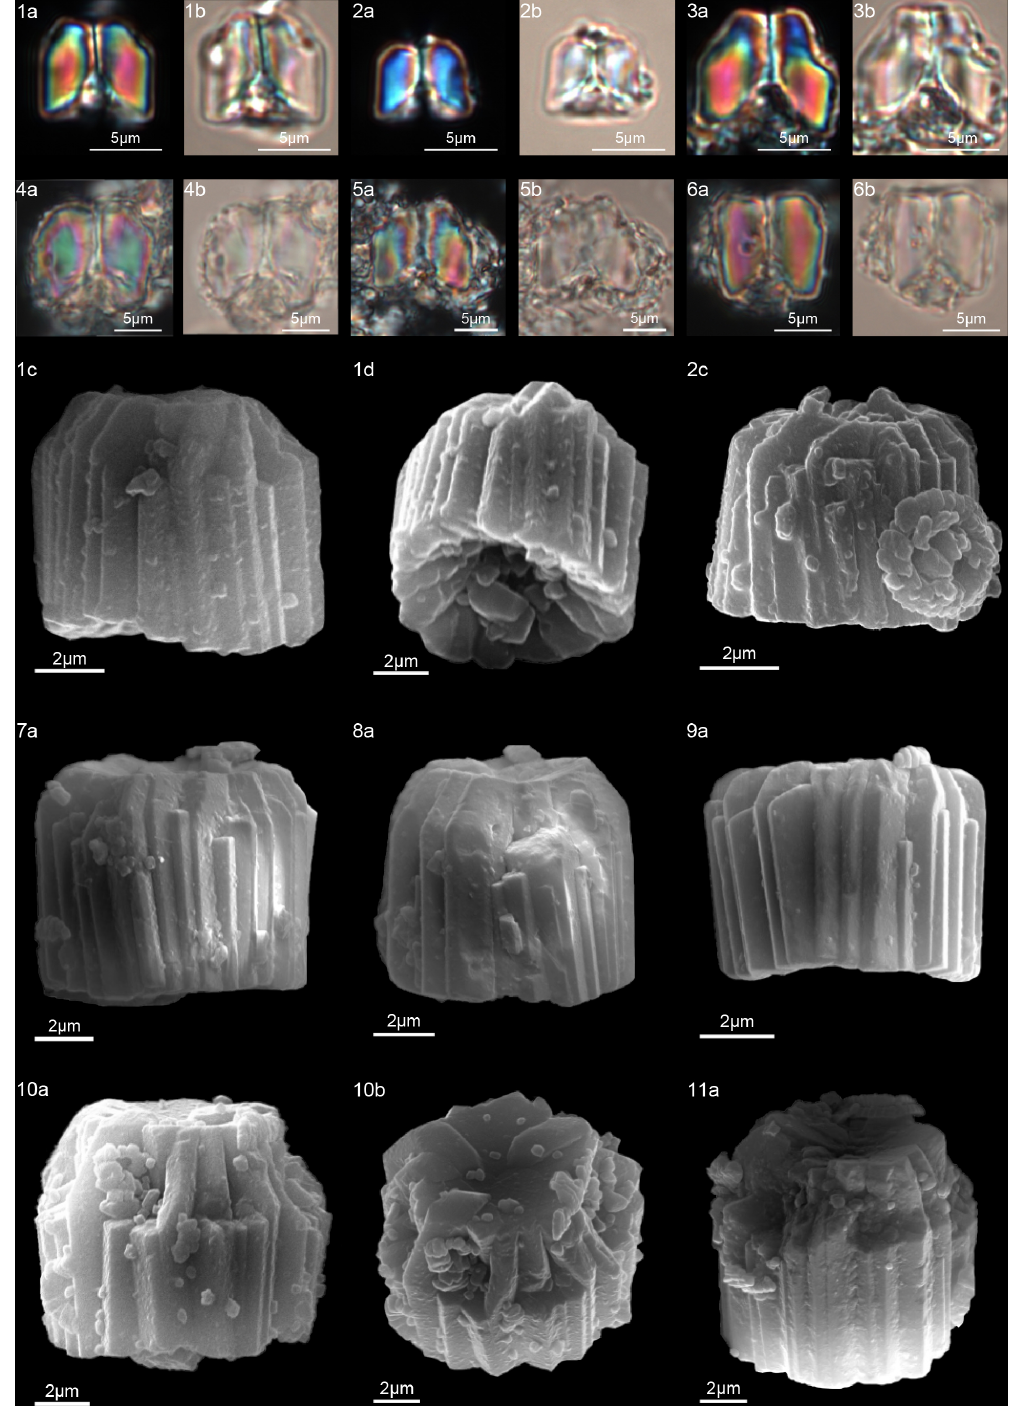
Figure 8. Gomphiolithus magnus . (1) Sample: 1209B 25-1, 142–143. (1a) Cross-polarized light (XPL). (1b) Plane-polarized light (PPL). (1c–d) Scanning electron microscope (SEM) images showing lateral (1c) and proximal view (1d) . (2) Sample: 1209B 25-1, 142–143. (2a) XPL, (2b) PPL, (2c) SEM. (3) Sample: 1209B 25-1, 142–143. (3a) XPL, (3b) PPL. (4) Sample: Contessa Highway 10.79m (above the K–Pg boundary). (4a) XPL, (4b) PPL. (5) Sample: Bottaccione 10.60m (above the K–Pg boundary). (5a) XPL, (5b) PPL. (6) Sample: Bottaccione 11.38m. (6a) XPL, (6b) PPL. (7) Sample: 1262C 11-5, 131–132. (7a) SEM. (8) Sample: 1262C 11-5, 131–132. (7a) SEM. (9) Sample: 1262C 11-5, 131–132 (201.34mcd). (7a) SEM. (10) Sample: 1209B 25-1, 142–143; SEM images showing lateral (10c)